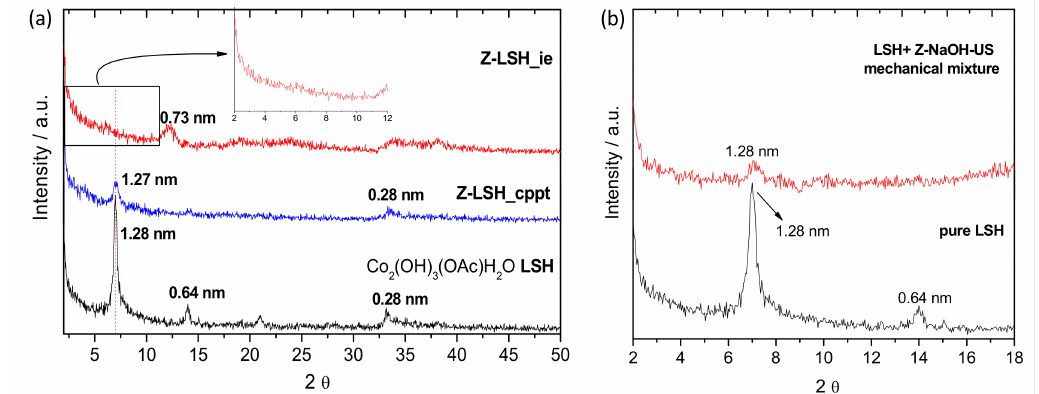
Figure 8. ( a ) XRD patterns of pristine Co-LSH, and Z-LSH_cppt and Z-LSH_ie biohybrids prepared by co-precipitation and ion-exchange methods, respectively; ( b ) XRD patterns of pristine Co-LSH containing acetate anions and the mechanical mixture based on Co-LSH and Z-NaOH-US. FTIR spectroscopy was used to examine the possible interactions between the protein and the − 1 Co-LSH host in the Z-LSH_ie biohybrid (Figure 9). Together with the bands below 800 cm assigned to the metal-oxygen vibrations of the Co-LSH framework, also observed in the spectrum of the pristine − 1 LSH (Figure 9 a), the spectrum of Z-LSH_ie shows other specific bands between 2970–2850 cm associated with ν C-H vibration mode of the biopolymer (Figure 9b). In this last spectrum, the shifts − 1 − 1 in the bands at 1650 cm and 1534 cm ascribed to the C = O and C–N vibration modes can be detected in comparison to those of the Z-NaOH-US spectrum (Figure 9c). These di ff erences could indicate the existence of interactions between the biomacromolecule and the LSH, as explained in the characterization of Z-LDH biohybrids (Figure 5). In the case of LSH, the presence of the functional groups of the intercalated anion (e.g., carboxylate groups from the acetate species) may help to favor the interaction of the protein producing di ff erent hybrid structures (e.g., exfoliated). In fact, the − − 1 antisymmetric and symmetric stretching vibration modes of COO groups, appearing at 1577 cm − 1 and 1404 cm , respectively in the pristine LSH (Figure 9a), disappear in the spectrum of the biohybrid material, indicating the removal of the acetate anion from the